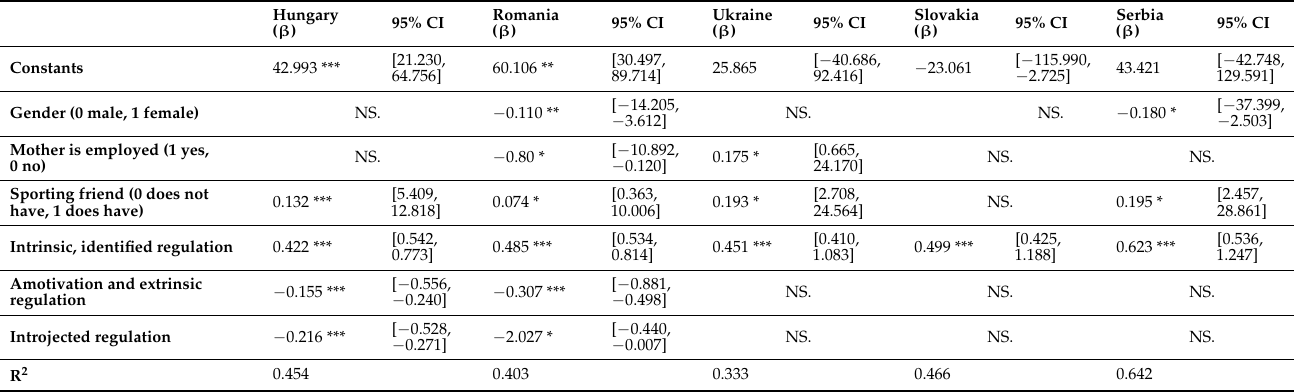
Table A3. The effect of demographic, sociocultural, economic, societal, and individual variables on the frequency of sport activity by country ( β regression coefficients). Source: PERSIST 2019 (N =